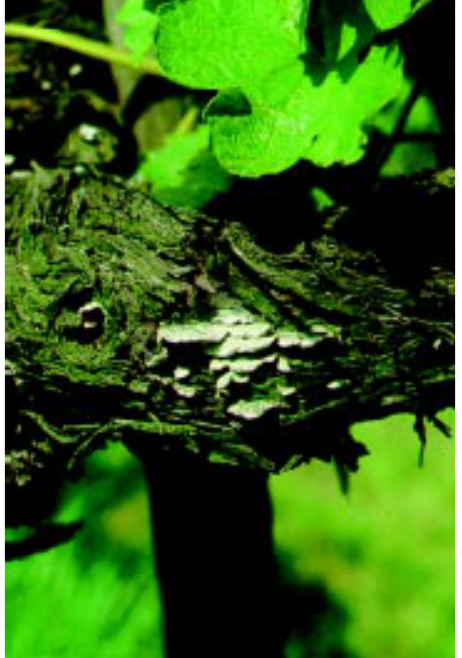
Fig. 4. Basidiocarps of Stereum hirsutum on the vine without esca symptoms on the leaves or